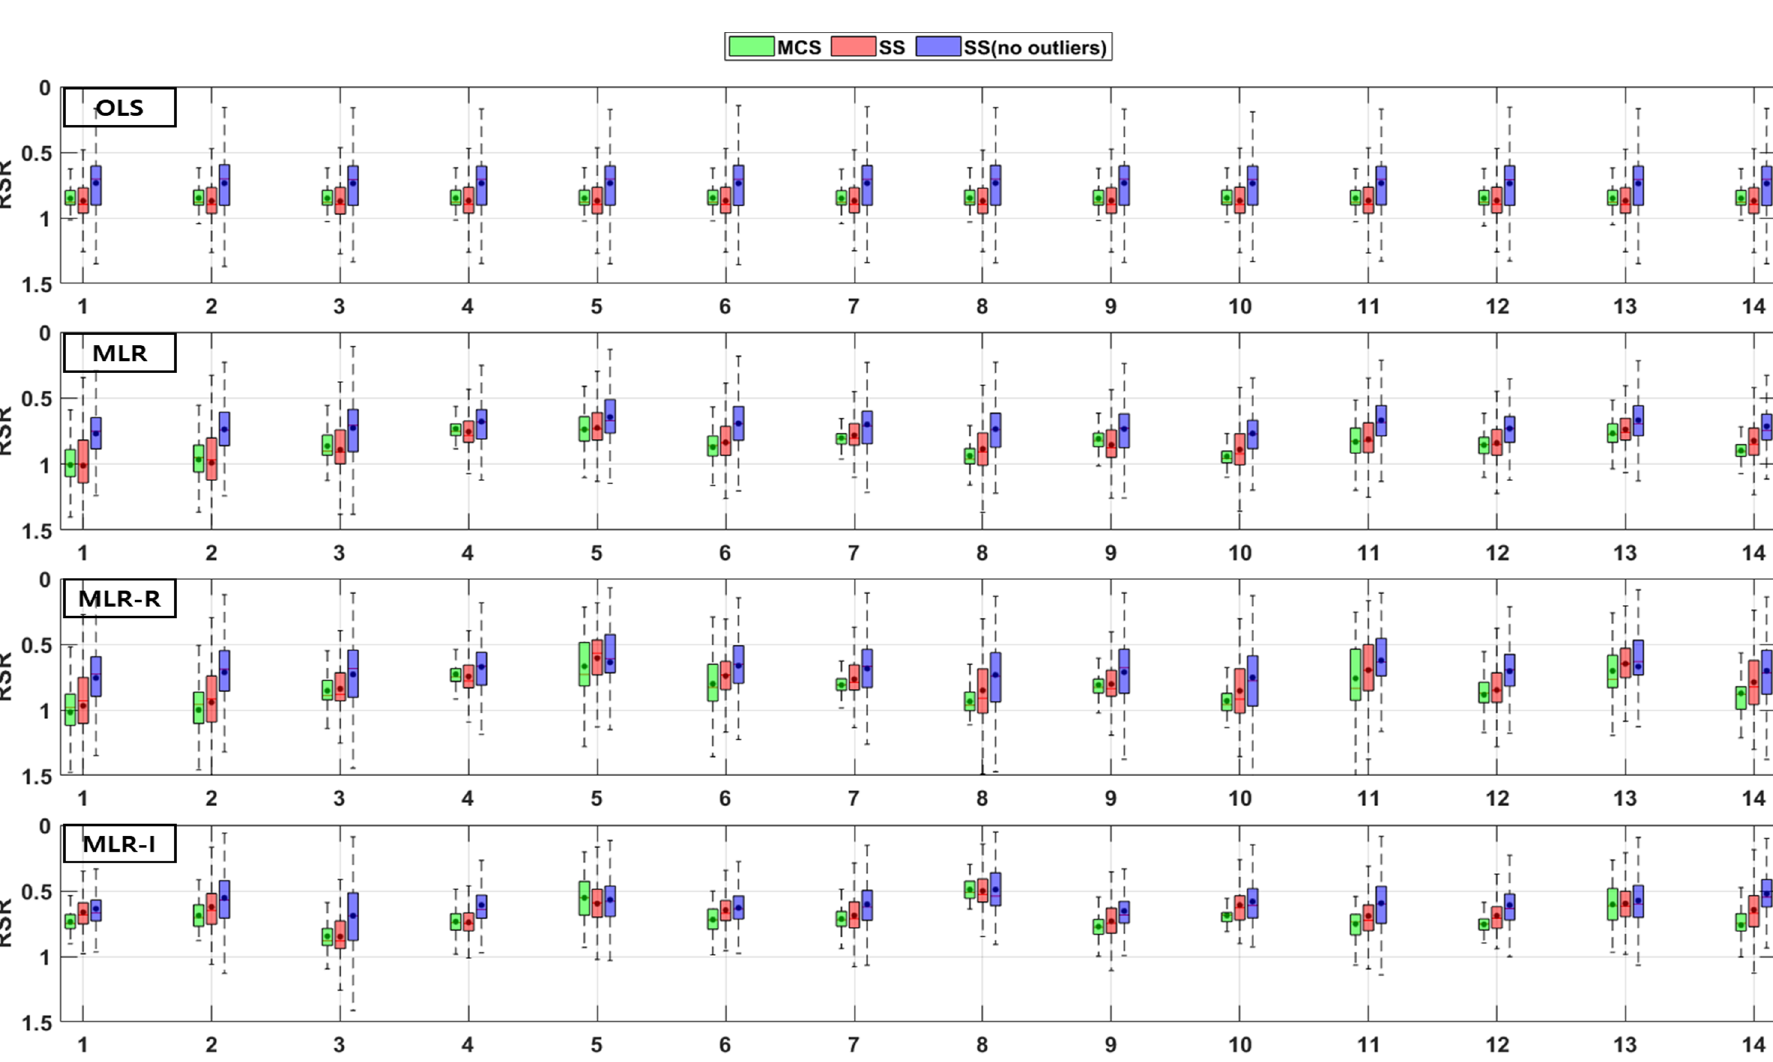
Figure 14. Error analysis (RSR) results of TP removal in retention ponds.